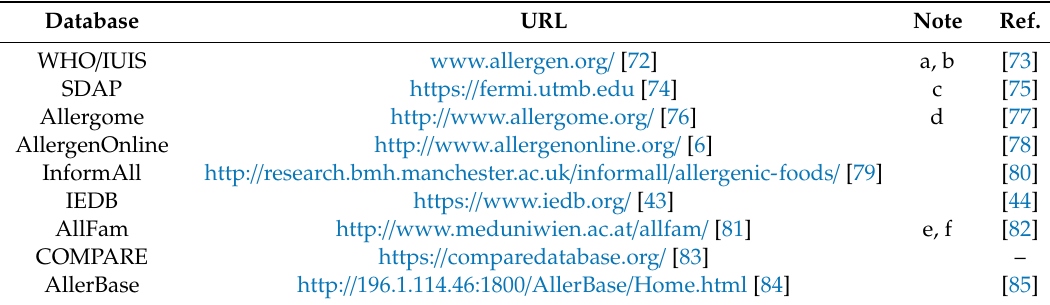
Table 1. List and web sites of the main databases on